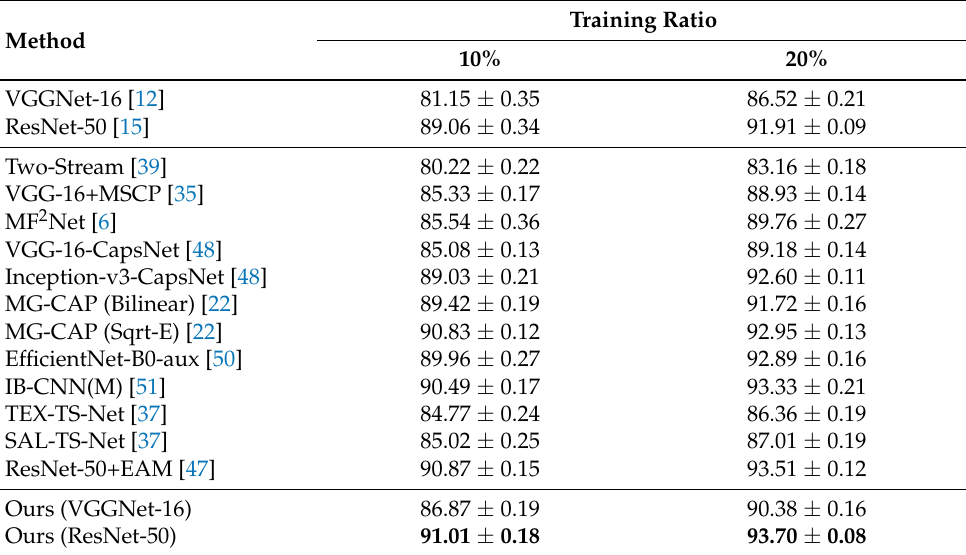
Figure 11. Confusion matrix of the proposed method on the AID dataset with a training ratio of 20%. Table 4. Overall accuracy and standard deviation (%) of different methods on the NWPU-RESISC45